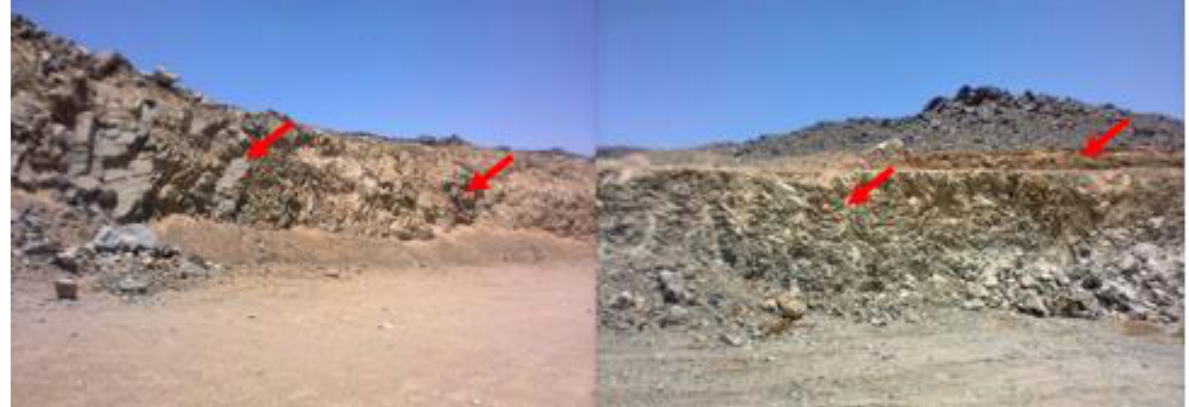
Figure 3. Field pictures from the Hamash gold mine and signed arrows show the location of collected samples (metavolcanic rocks on the left and younger granite on the right).